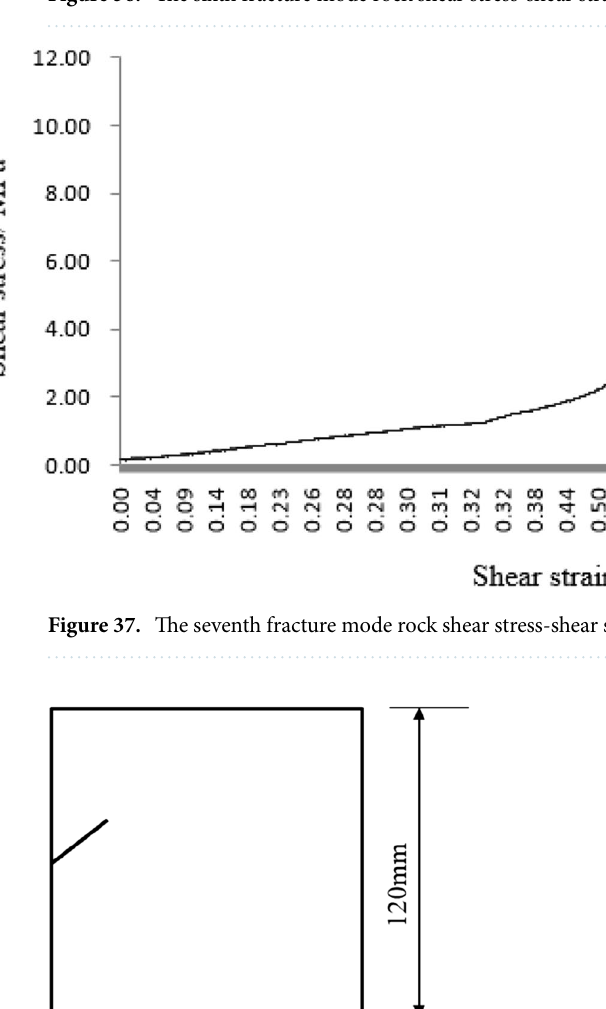
Figure 36. The sixth fracture mode rock shear stress-shear strain curve.